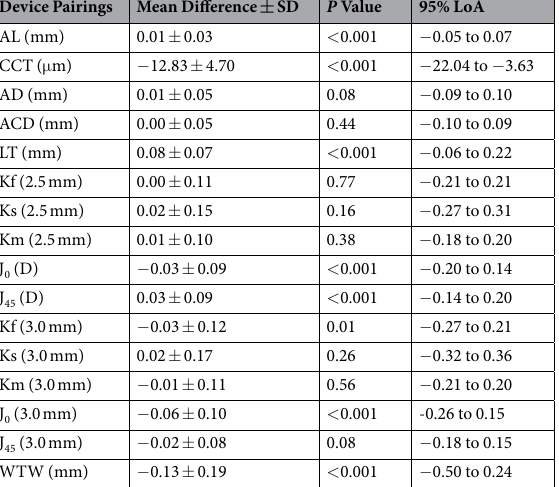
Table 2. Agreement of biometric measurements between the OA-2000 swept-source optical coherence tomography and Lenstar optical low coherence reflectometry. AL = Axial length, CCT = central corneal thickness, AD = aqueous depth, ACD = anterior chamber depth, LT = Lens thickness, Kf = flattest keratometry, Ks = steepest keratometry, Km = mean keratometry, WTW = white to white, SD = standard